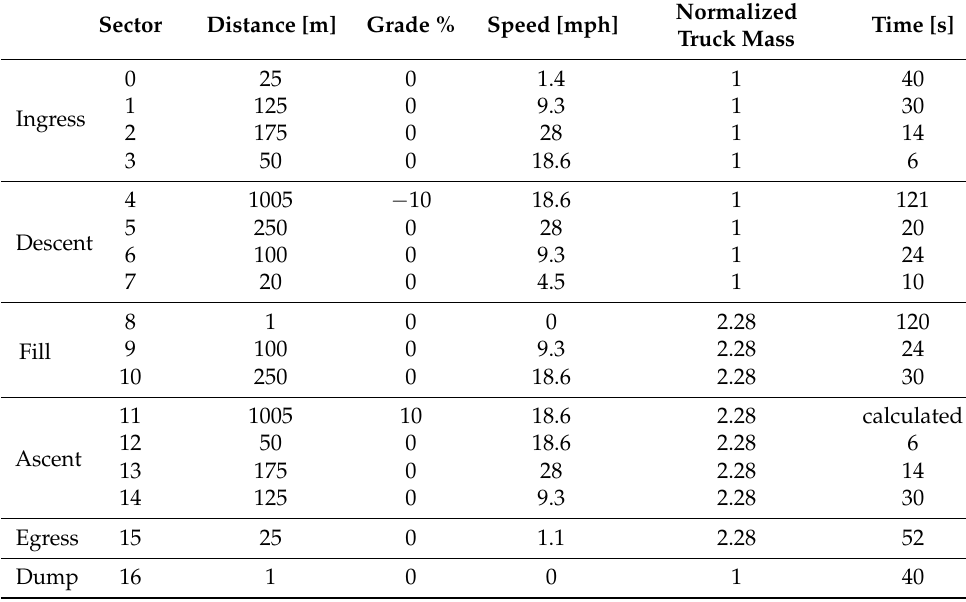
Table 1. Haul route from Reference [23].